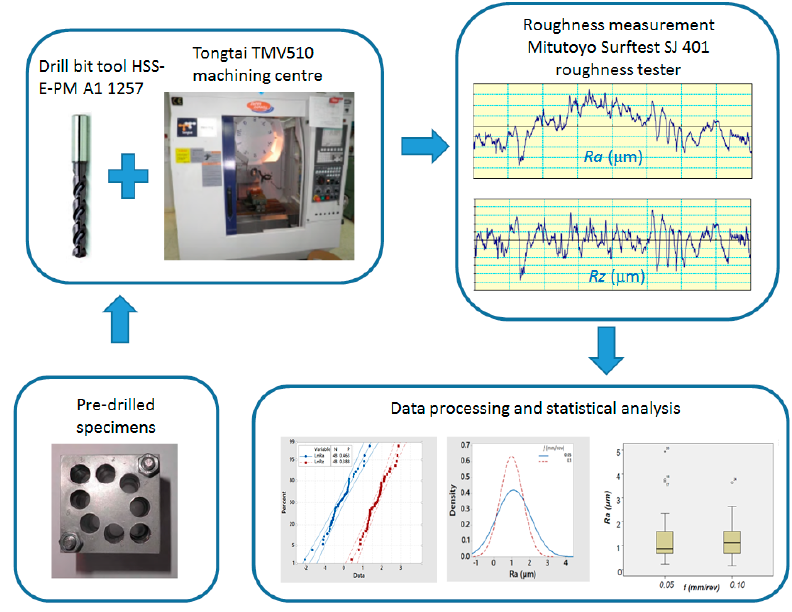
Figure 4. The experimental set-up.